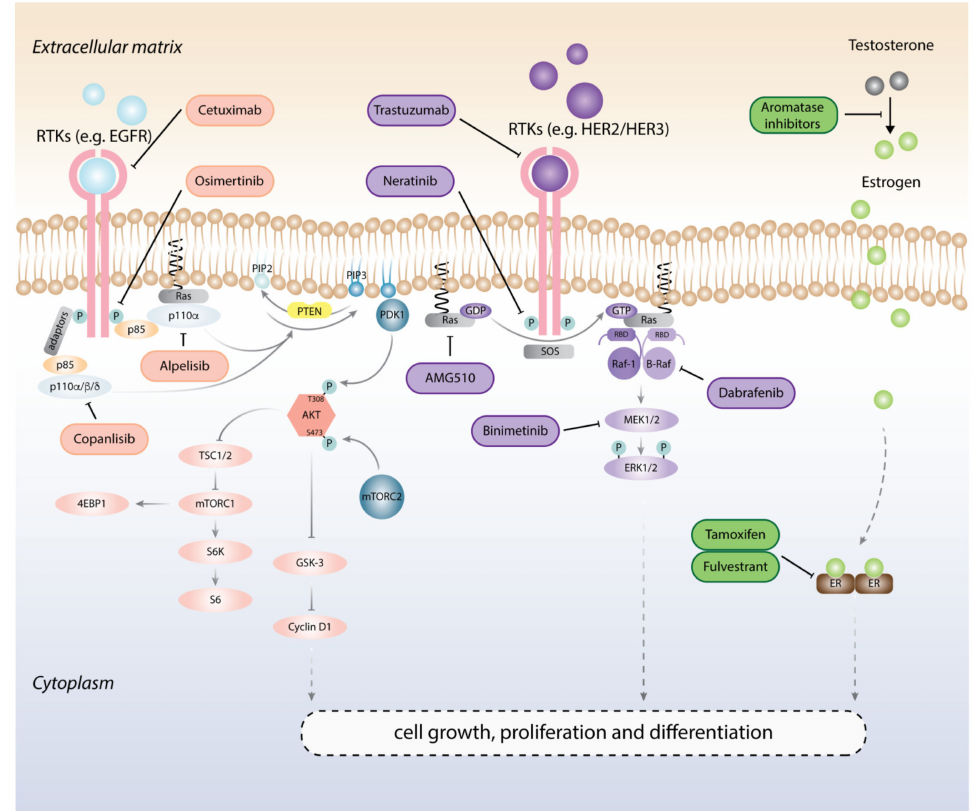
Figure 1. Targeted therapies for cancer treatment. In physiologic conditions, ligands bind to receptor tyrosine kinases (RTKs) at the cell membrane and induce the autophosphorylation of the RTKs’ catalytic domains and the activation of downstream effectors, e.g., p85 release and the activation of the p110 catalytic subunit within PI3K; GDPase–GTPase conversion of Ras. Activation of the PI3K and MAPK pathways initiates a series of phosphorylation events that promote cell growth and proliferation and regulate cellular differentiation. In the presence of estrogen, the estrogen receptor (ER) dimerizes and translocates into the nucleus where it activates pro-growth transcription programs. Examples of FDA-approved monoclonal antibodies and small molecule inhibitors acting on multiples molecular nodes are